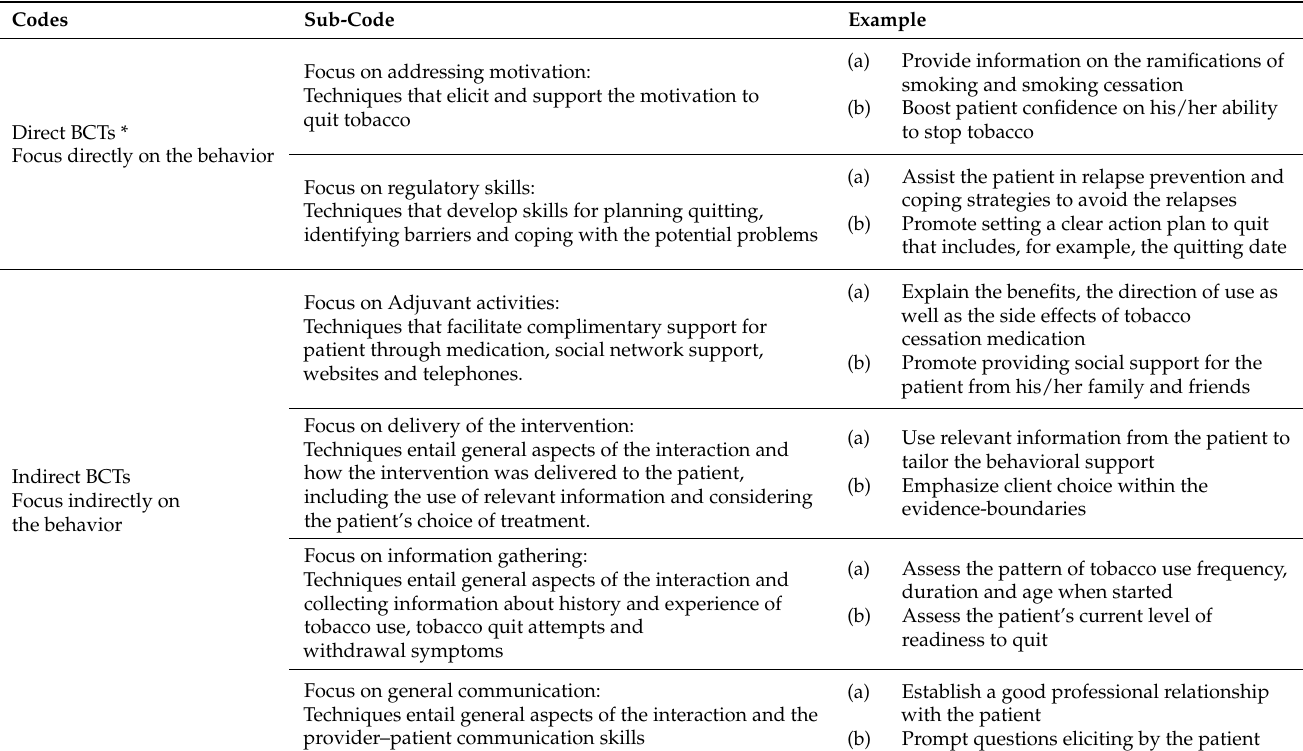
Table 1. Codes and sub-codes of the behavior change techniques used in tobacco cessation intervention.